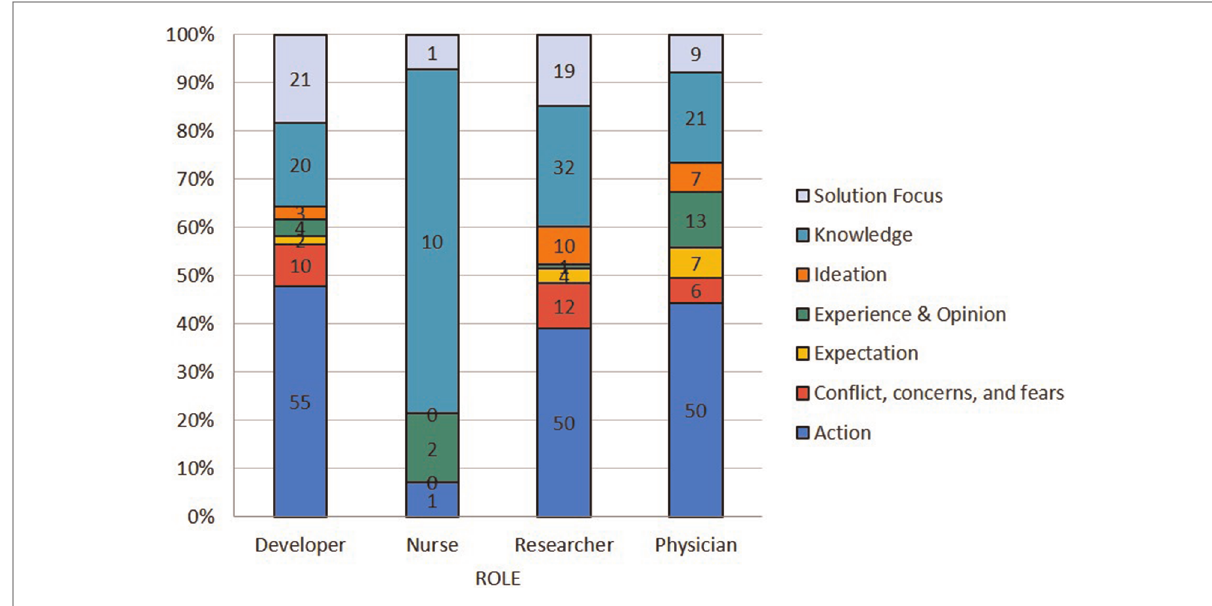
FIGURE 4 Different contributions according to PAR team role.